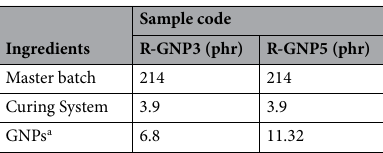
Table 3. The composition of R-GNP nanocomposites. a Unit is in parts per hundred parts of rubber (phr).